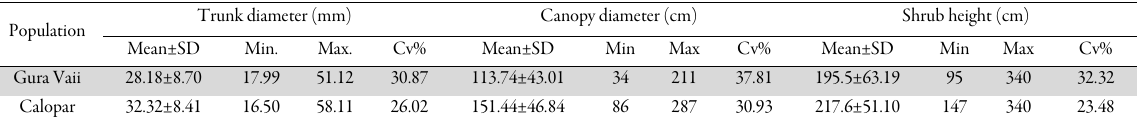
Table 3. Average, maximum and minimum values / per population of trunk and canopy diameters and shrub height Population